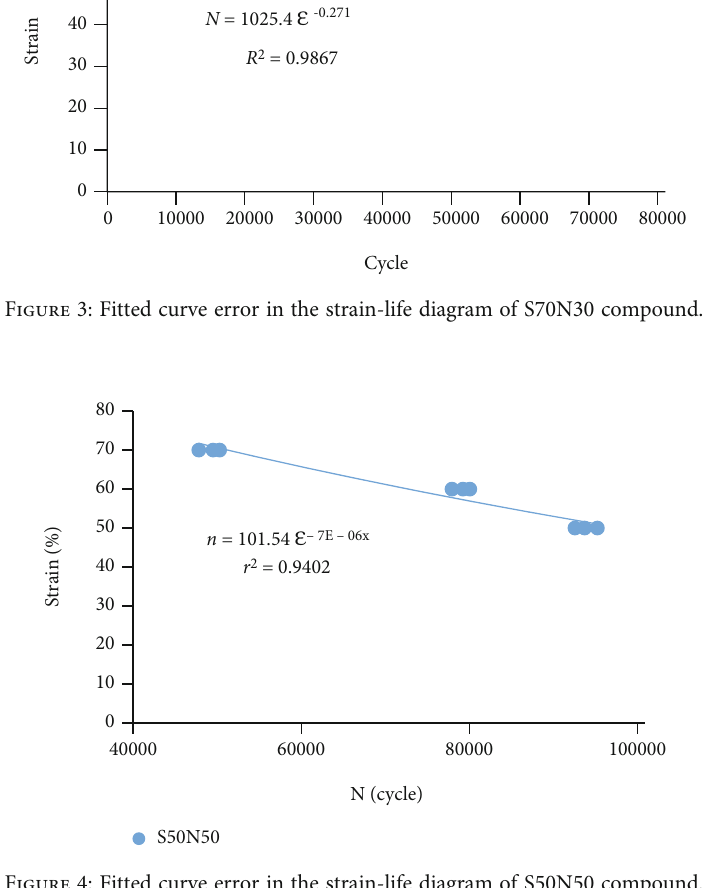
N = 1025.4 Ɛ -0.271